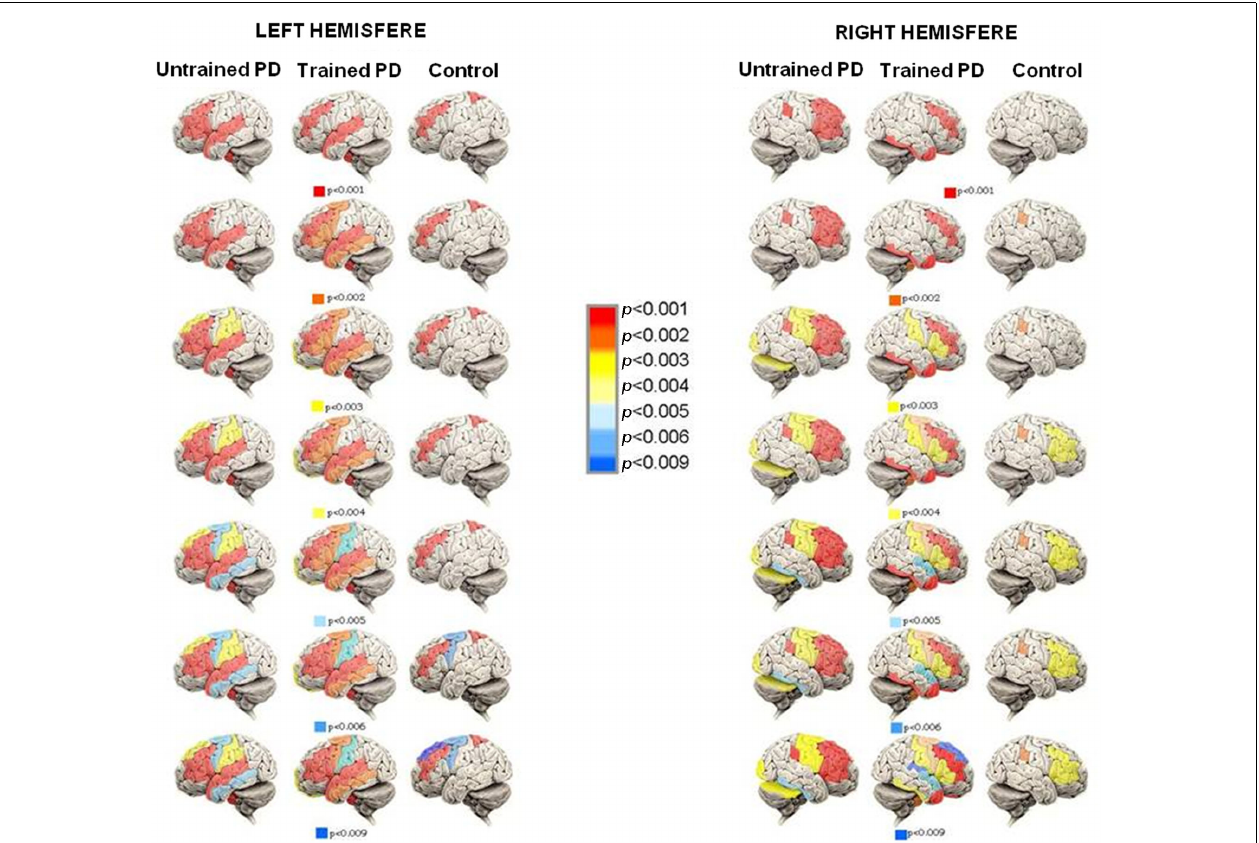
and so on for p values up to 0.009. At p values equal to 0.009 a significant increase in the number of activated areas was still evident when compared with the controls (control > trained > untrained), as also occurred at p = 0.001. One permanent characteristic is that PD patients require the recruitment of more areas to solve the task, and more in untrained patients than in trained ones, confirming the differences that training had on these